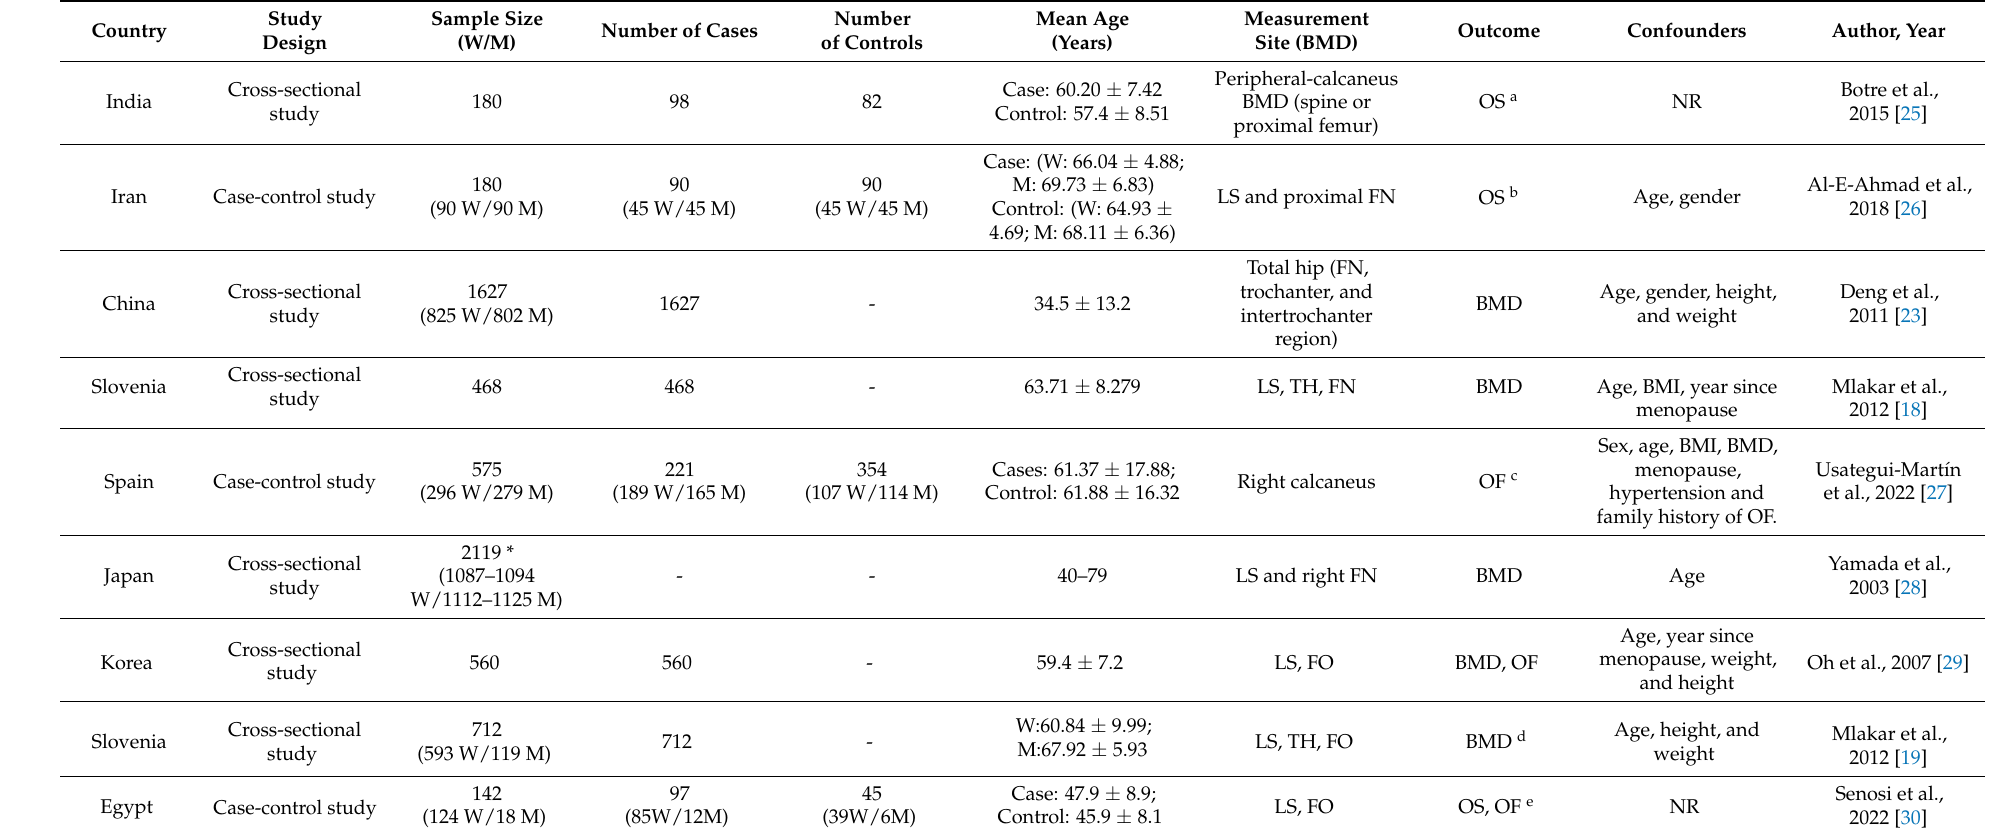
Table 1. Summary of studies included in the systematic